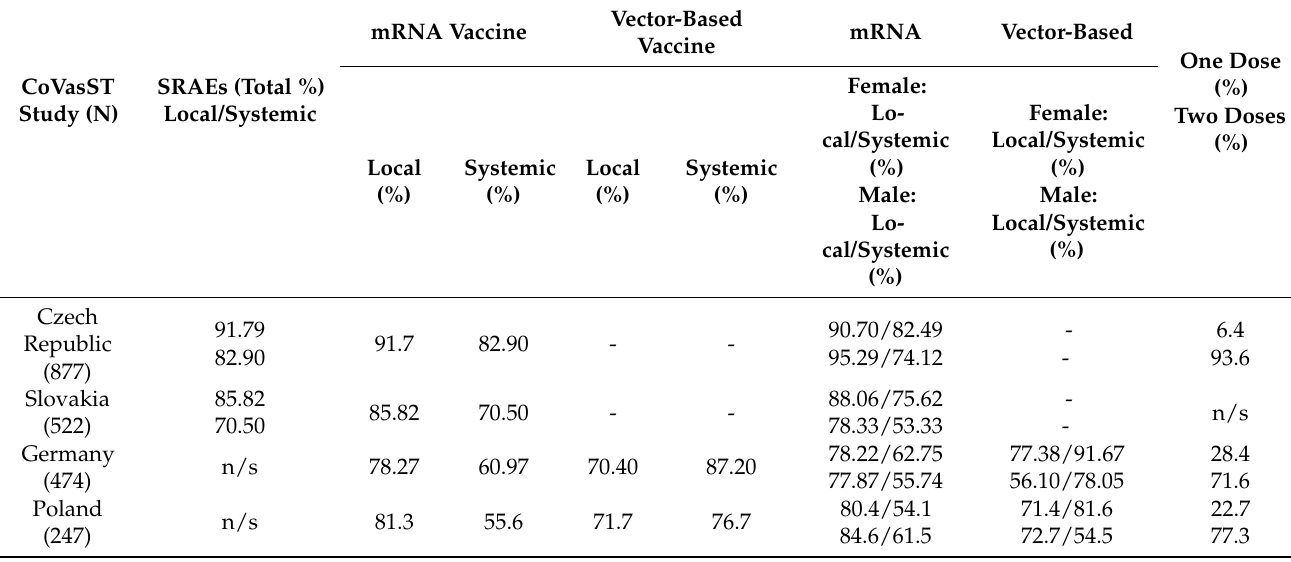
Table 11. The comparison of cross-sectional CoVaST studies results; post-vaccination adverse events in HWs associated with COVID-19